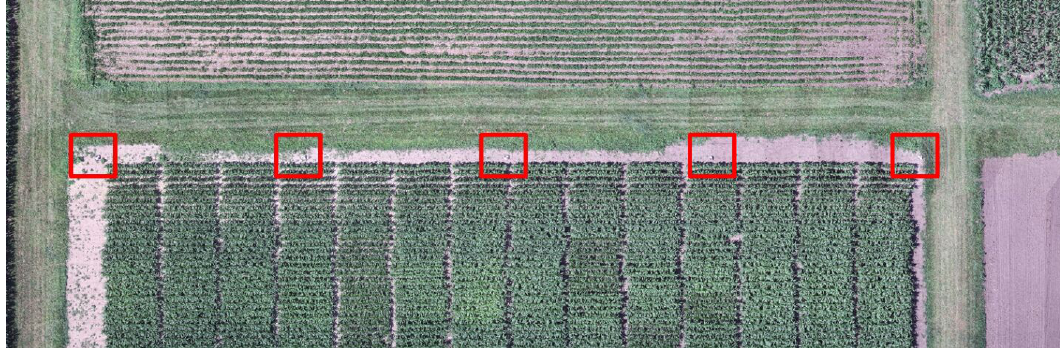
Figure 23. Orthophoto result from direct approach for FLIR RGB July 25th data collection (red boxes show the location of the check points, Original Image GSD ≈ 0.01 m ).